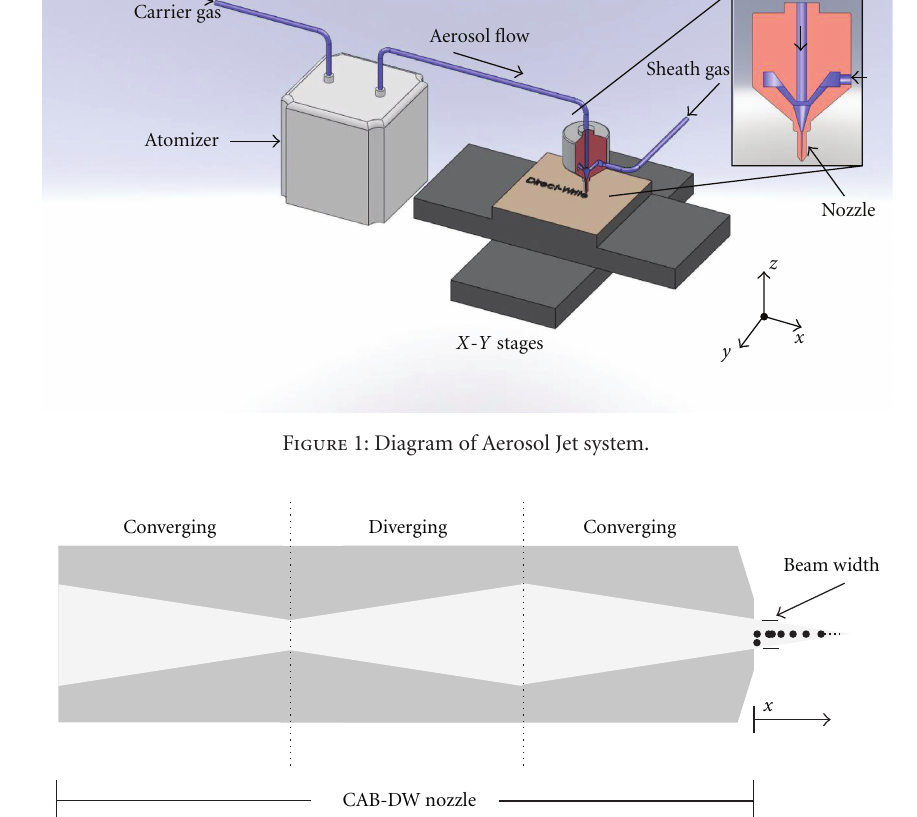
other device components such as interlayer dielectrics.